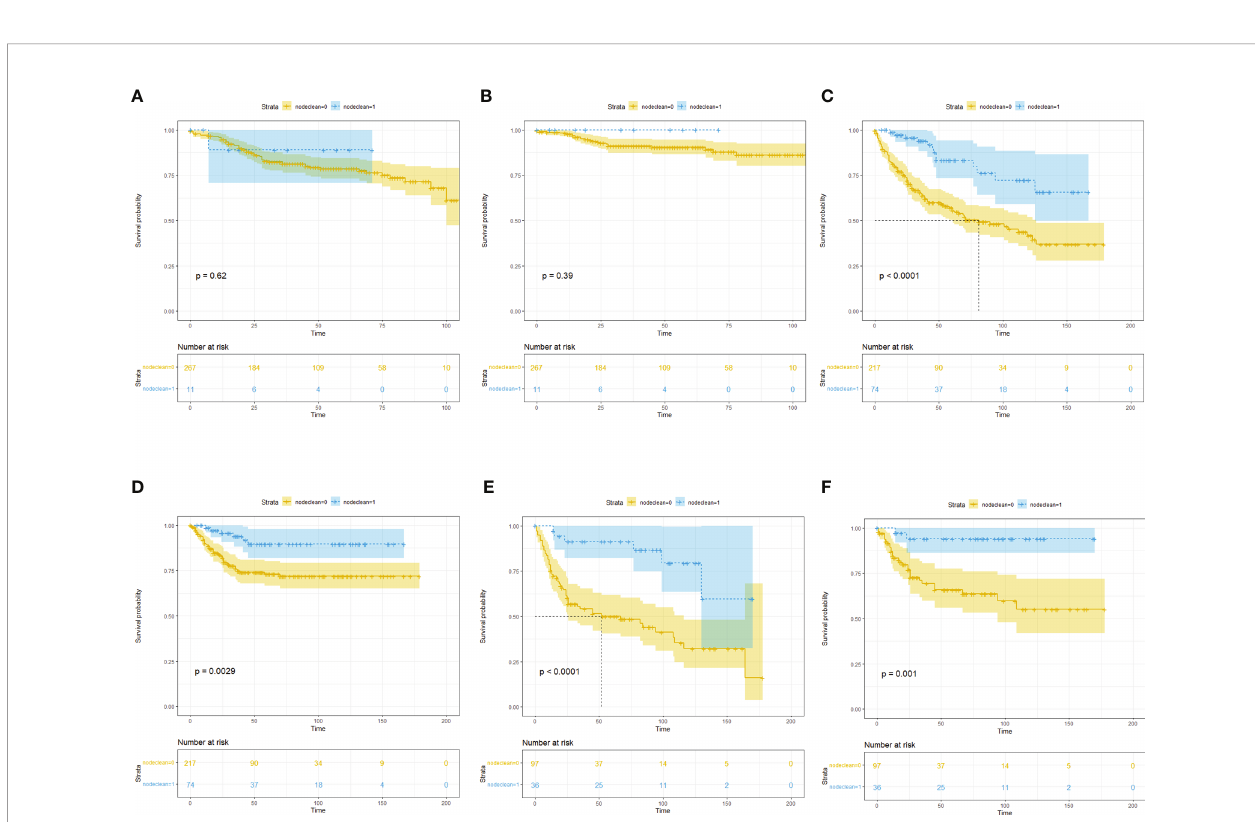
FIGURE 4 | Subgroup Kaplan – Meier survival analysis for LND. (A) Overall survival in the Ta, T1a (G1, G2) subgroup. (B) Cancer-speci fi c survival in the Ta, T1a (G1, G2) subgroup. (C) Overall survival in the T1b (G3) and T2 subgroup. (D) Cancer-speci fi c survival in the T1b (G3) and T2 subgroup. (E) Overall survival in the T3 (any G) subgroup. (F) Cancer-speci fi c survival in the T3 (any G)